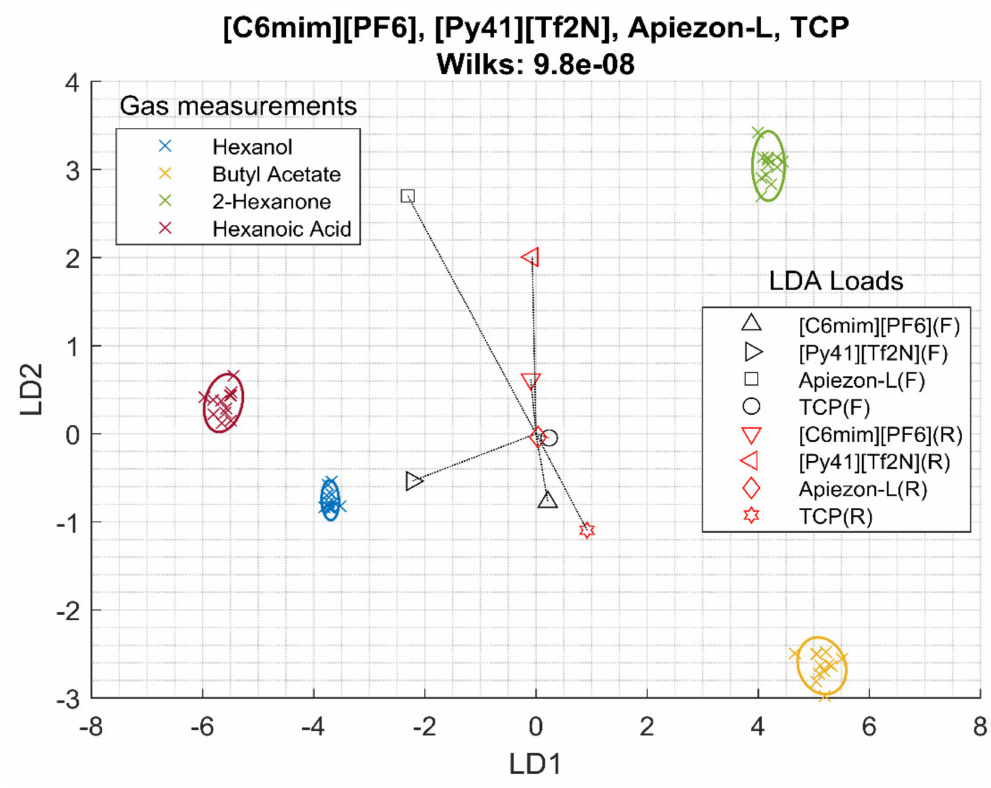
Figure 4. LDA of all sensors and all data points using frequency (F) and resistance (R)